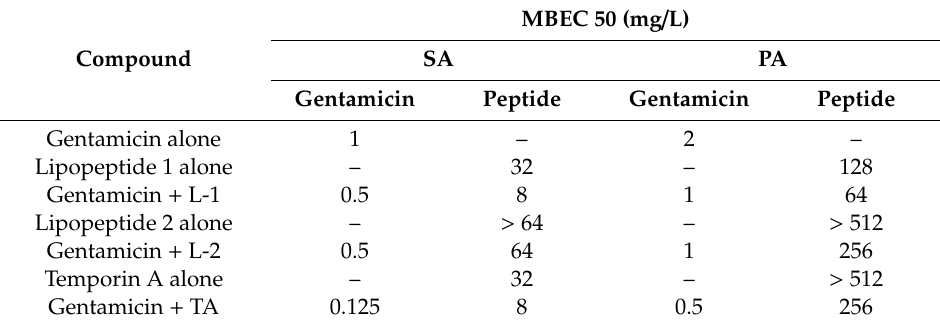
Table 4. MBEC 50 (mg / L) obtained for combinations of gentamicin and antimicrobial peptides against SA and